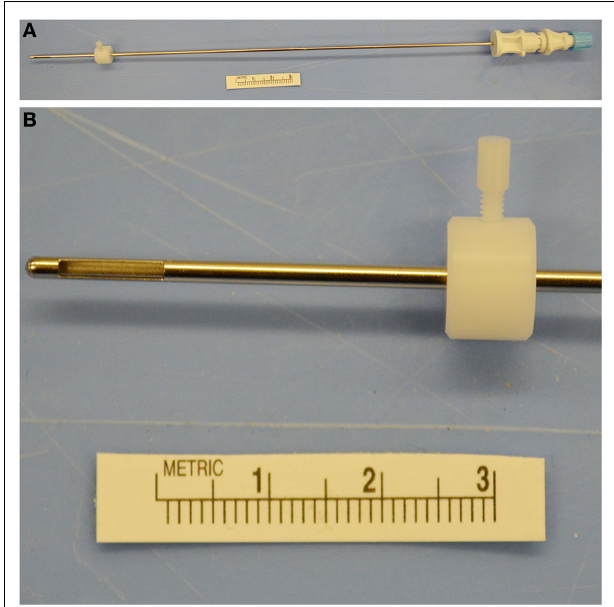
FIGURE 3 | Nashold needle with Luer lock proximal end (A) and 10mm side-cutting channel with depth stop (A,B) used for canine brain biopsy procedures .